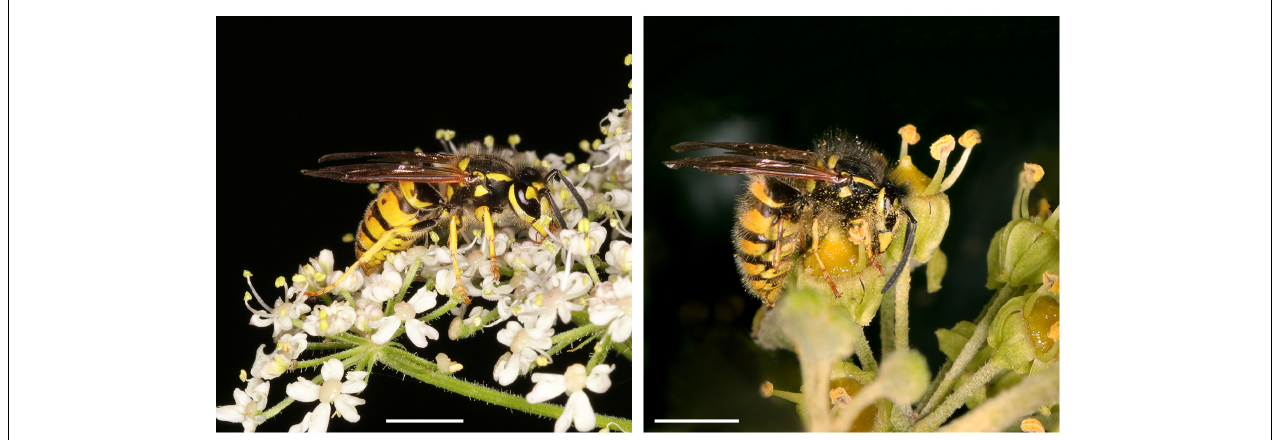
FIGURE 1 | Vespula germanica wasp visiting inflorescences of Heracleum sphondylium (left) and Vespula vulgaris wasp visiting inflorescences of Hedera helix (right) . Scale bars correspond to 0.5